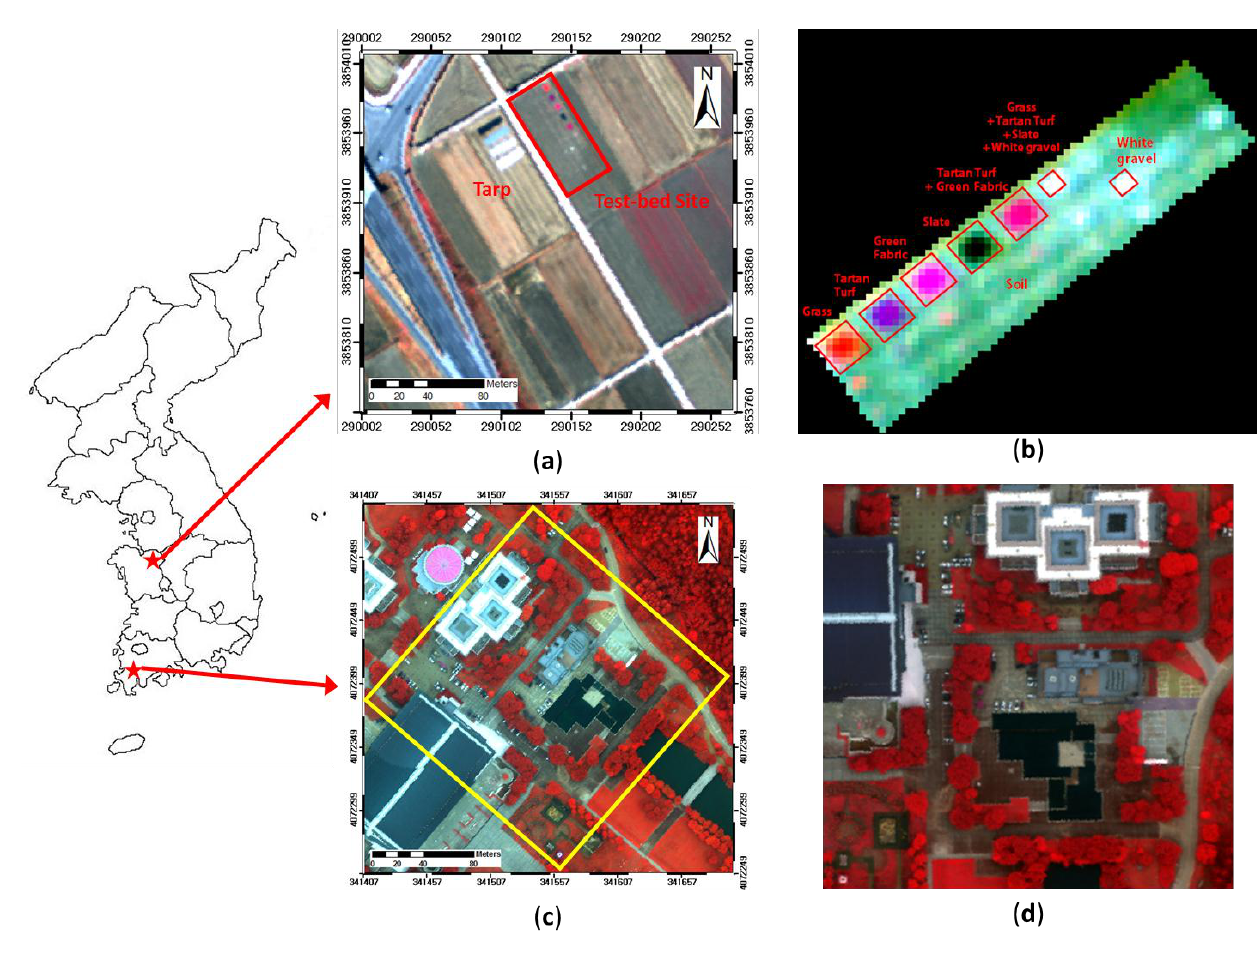
Figure 4. ( a ) AISA image featuring the test bed in the UTM (WGS 84, 52S zone) coordinate system: red is band 97 (845–849 nm), green is band 65 (688–693 nm), and blue is band